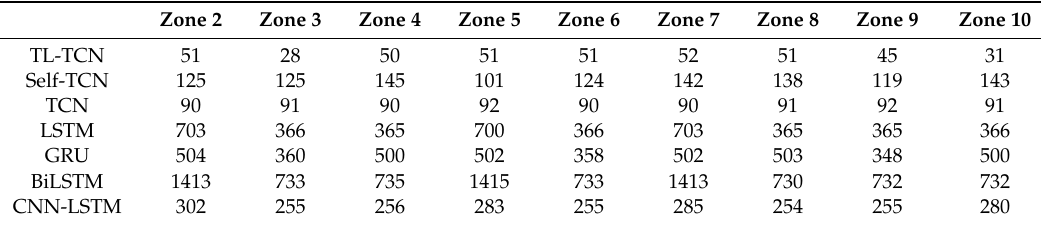
Table 12. Running time of each model (the unit is seconds).